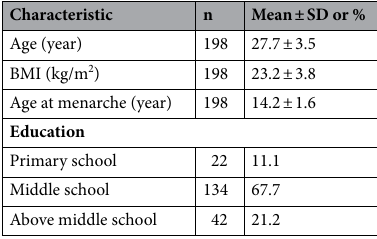
Table1. Characteristics of